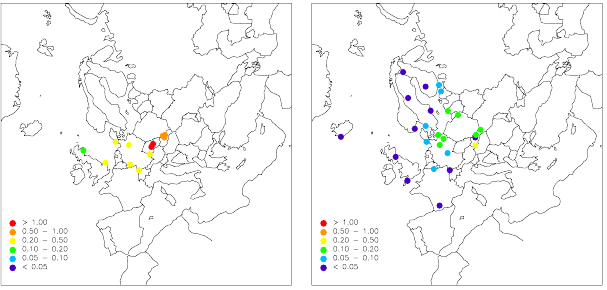
Fig. 20. Average concentrations of Cd in aerosols in 1990 and 2009 (unit ng Cd m − 3 )